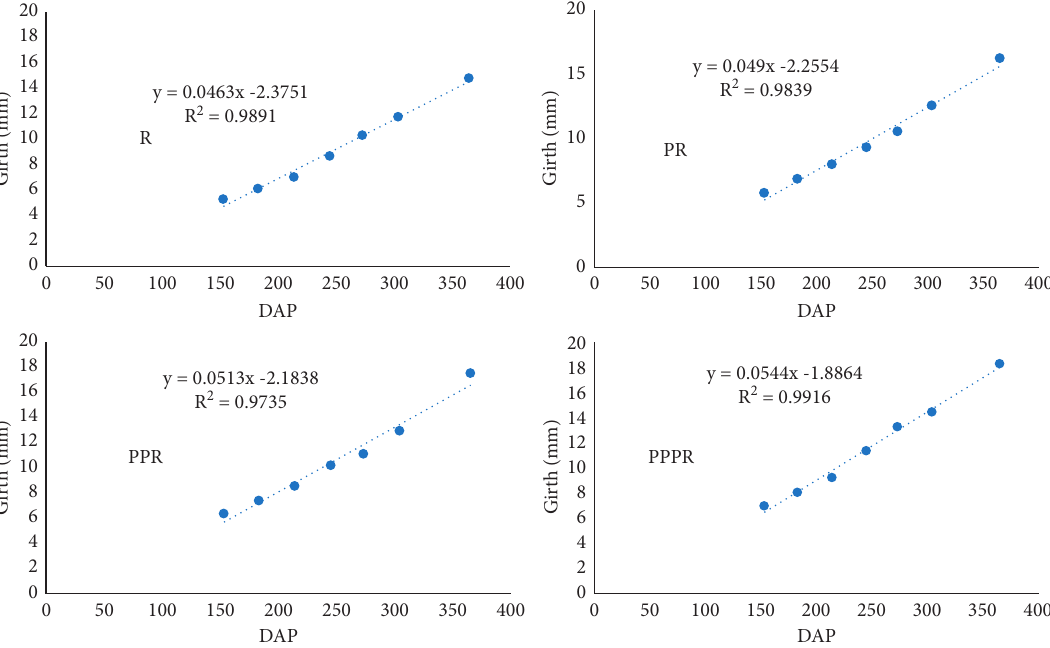
Figure 5: Correlation between girth and days after planting (DAP) of rubber in the rubber-plantain intercropping systems at Ellembelle study site, Western region, Ghana. R � sole rubber; PR � low-density plantain; PPR � medium-density plantain; PPPR � high-density plantain.